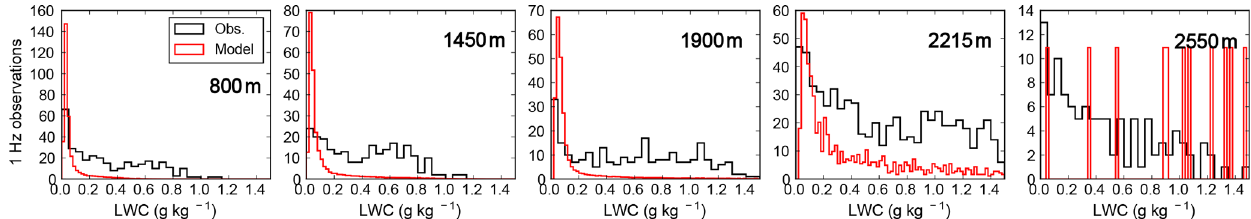
Figure 6. Frequencies of observed in-cloud liquid water contents from the cloud droplet probe compared to the liquid water contents in cloudy grid cells in the 500m resolution simulation at the five altitudes marked. We include all model grid cells at the specified altitude within the simulation domain with a liquid water content greater than 0.01gkg − 1 at the instant of 12:00UTC on 19 August in the histogram, except for the grid cells within 10km of the domain boundary. The histograms of the simulated liquid water contents are scaled to contain the same number of entries as the histograms of the observations (so, for example, there are 11 model grid boxes plotted at 2550m